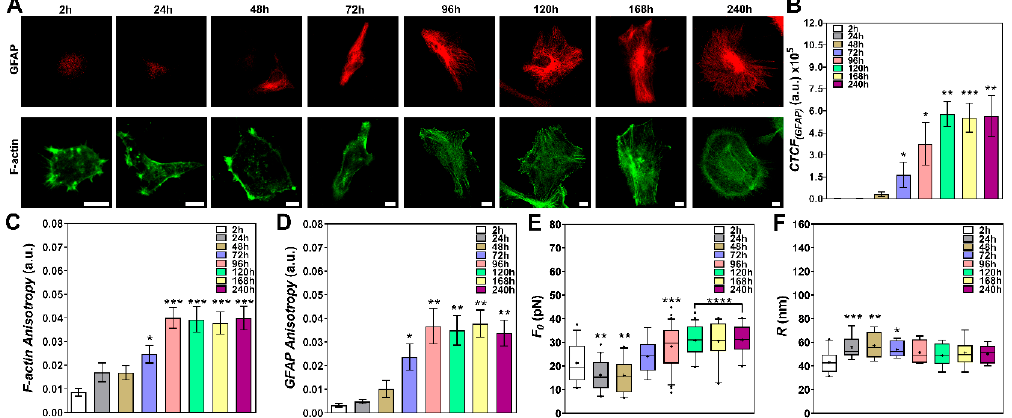
Figure 4. Tether extraction experiments and radius measurements for NPCs induced to differentiate into astrocytes. ( A ) Representative images of cells stained for GFAP (red) and F-actin (green) from 2 to 240h. Scale bars are all 10 μ m. ( B ) Plot of the mean CTCF values for GFAP within 2h to 240h of culture. ( C–D ) Plot of the mean anisotropy values of F-actin staining ( C ) and GFAP staining ( D ) after FibrilTool analysis. At least 10 different cells for each experimental condition were analyzed. Standard errors were used as error bars in B, C and D. They all show similar behaviors as the ones represented in A. ( E–F ) Plots of tether force (at least 16 different cells) ( E ) and tether radius values (at least 10 different cells) ( F ) for each time point. The colored boxes extend from 25th to 75th percentiles, with a black horizontal line at the median and a black cross at the mean; black whiskers extend from 5th to 95th percentiles; values outside these ranges are plotted as individual points. * means p < 0.05, ** means p < 0.01, *** means p < 0.001, **** means p < 0.0001 in Mann-Whitney U -test statistics when comparing each time point with the 2h condition. 3.5. The Differentiation Process for Oligodendrocytes Reveals Interesting Patterns that Correlate Cytoskeletal Remodeling and Expression of Specific Markers with Changes in CM Elastic Properties Finally, NPCs were also induced to differentiate into oligodendrocytes. Likewise, we followed the cell morphology during the process. Figure 5A shows the actin cytoskeleton (in green), together with two specific markers for oligodendrocytes: O4 (in red) and MBP (in white) [32]. Interestingly, the expression of O4 increased in the first hours of culture and then decreased after the 96-h time point. Conversely, the expression of MBP, which was low in the first hours, increased in the last hours, especially after the 96-h time point (Figure 5A). The antagonistic expression patterns between O4 and MBP become more evident in Figure 5B, where the ratios between O4 and MBP fluorescence intensities were plotted. The cell morphology and actin cytoskeleton organization also dynamically changed over time in culture. Cells initially presented a star-like branched morphology during the first 48 h, with several F-actin containing protrusions (Figure 5A). However, this ramified morphology changed to a more flat-like lamellar shape, with the formation of membrane extensions, after 72–96 h. These changes were correlated with the increase in MBP expression and the simultaneous decrease in O4 expression. Interestingly, in the same time frame, the actin cytoskeleton also presented peculiar changes in its architecture. These changes first appeared in the outermost region of the membrane extensions surrounding the cell as a sort of ring and then disappeared in the